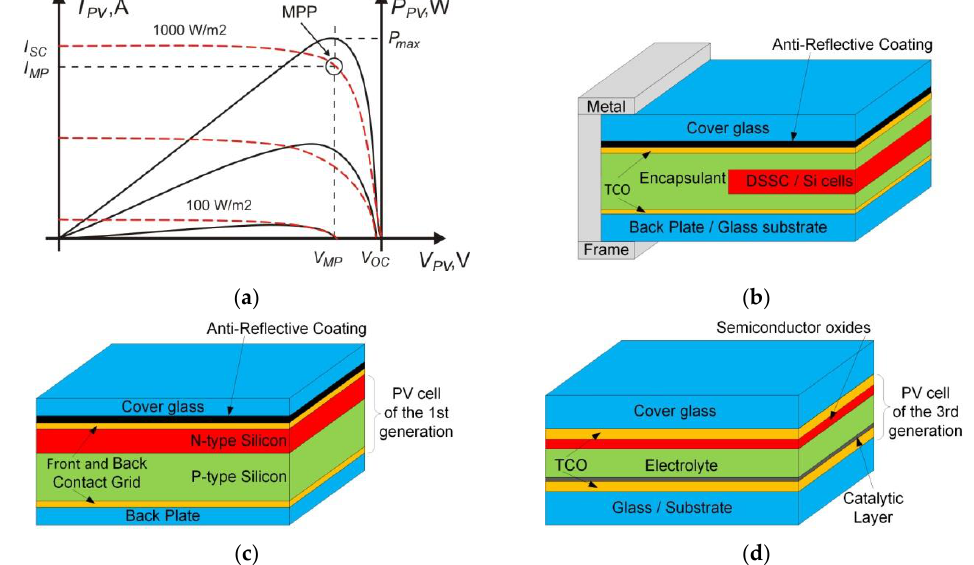
Figure 2. Photovoltaic (PV) panel. ( a ) I-V and P-V characteristics of a photovoltaic panel at solar irradiation from 100 to 1000 W / m 2 ; I SC —short-circuit current (at V PV = 0); V OC —open circuit voltage (at I PV = 0); V MP and I MP — voltage and current, respectively, at maximum power point (MPP). ( b ) Common structure of exemplary PV panel. ( c ) Common structure of PV cell of the first generation (Si—silicon). ( d ) Common structure of PV cell of the third generation (e.g., DSSC—dye-sensitized solar cell).